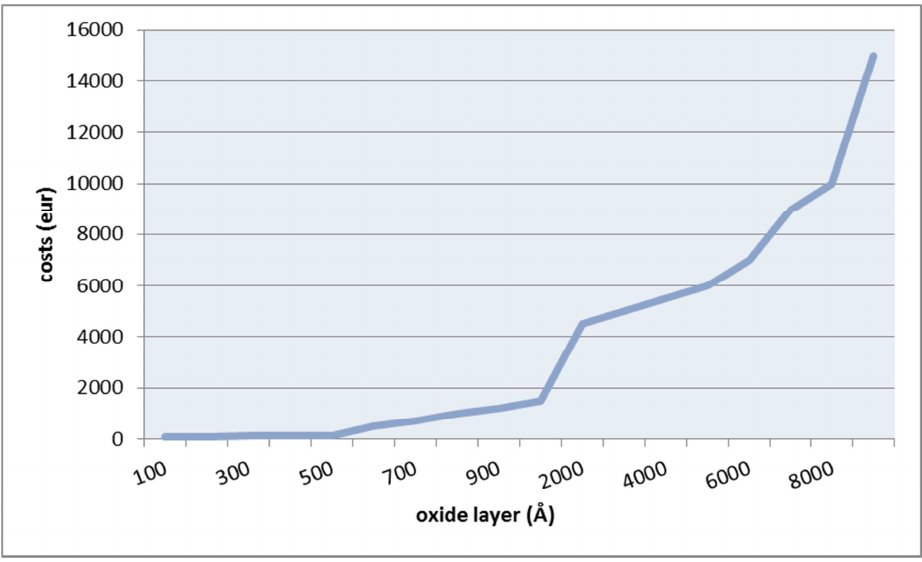
Figure 3 – Costs of OSH (Source: own